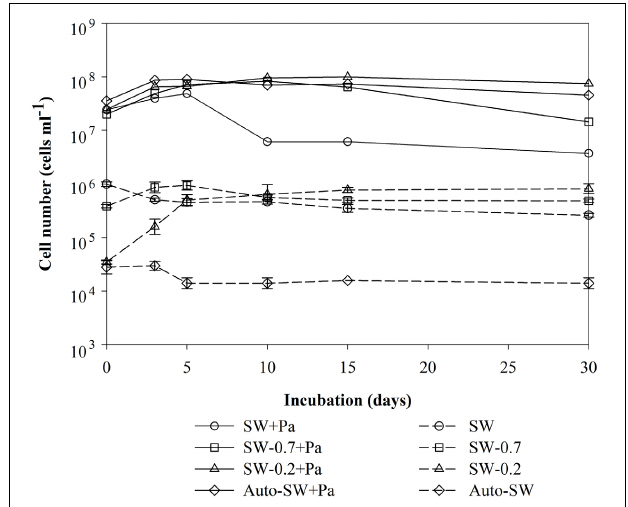
FIGURE 1 | Time-course analysis of changes in the number of bacteria in each microcosm over time. Each value is an average of duplicate (samples from Pa-containing microcosms) or triplicate (samples from Pa-free microcosms) counts. Error bars representing the standard deviations for the